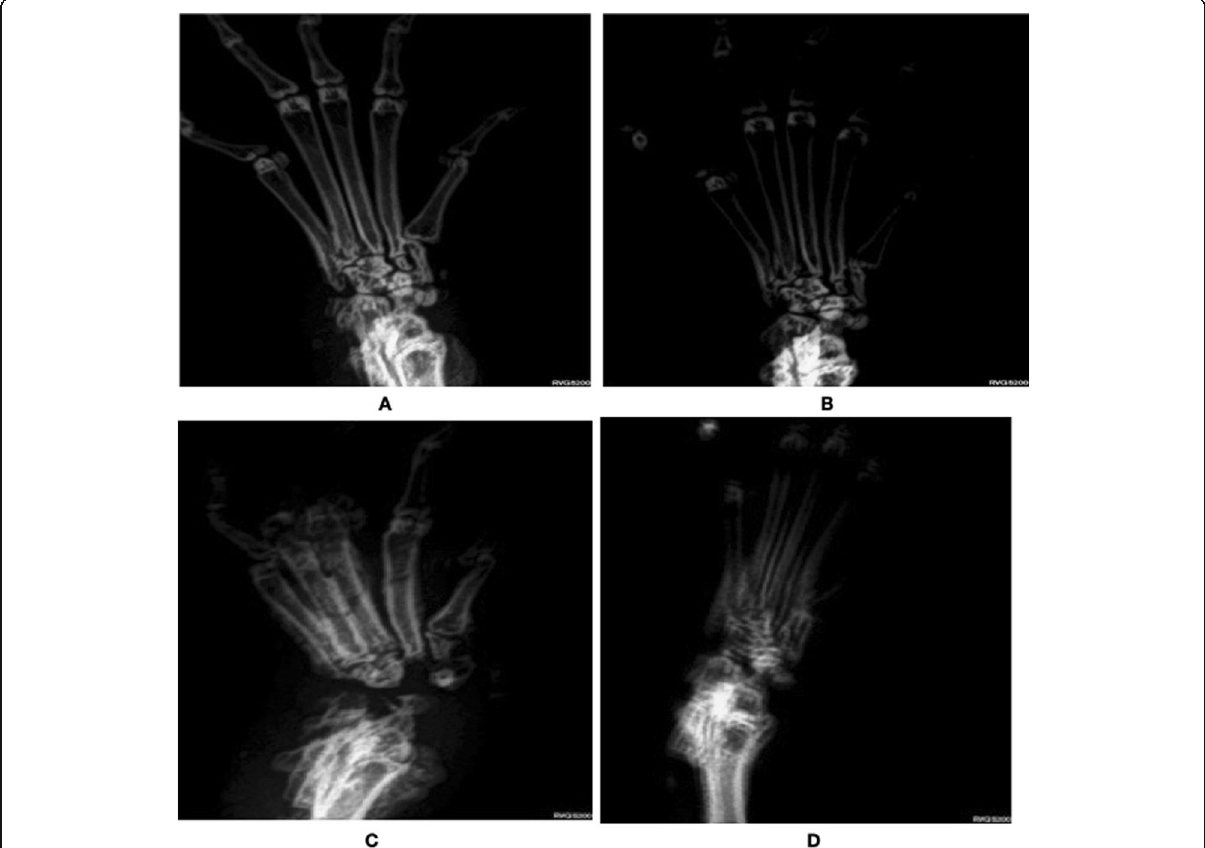
Fig. 2 Effect of Martynia annua L. extract on CFA induced paw edema in rats. a = Control group, b = Low dose group (200 mg/kg), c = High dose group (400 mg/kg), d =